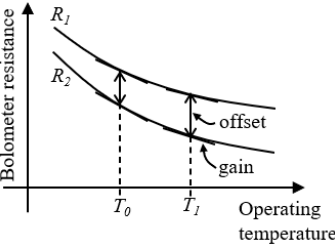
Figure 1. Non-uniform resistance changes in two bolometers according to the operating temperature.